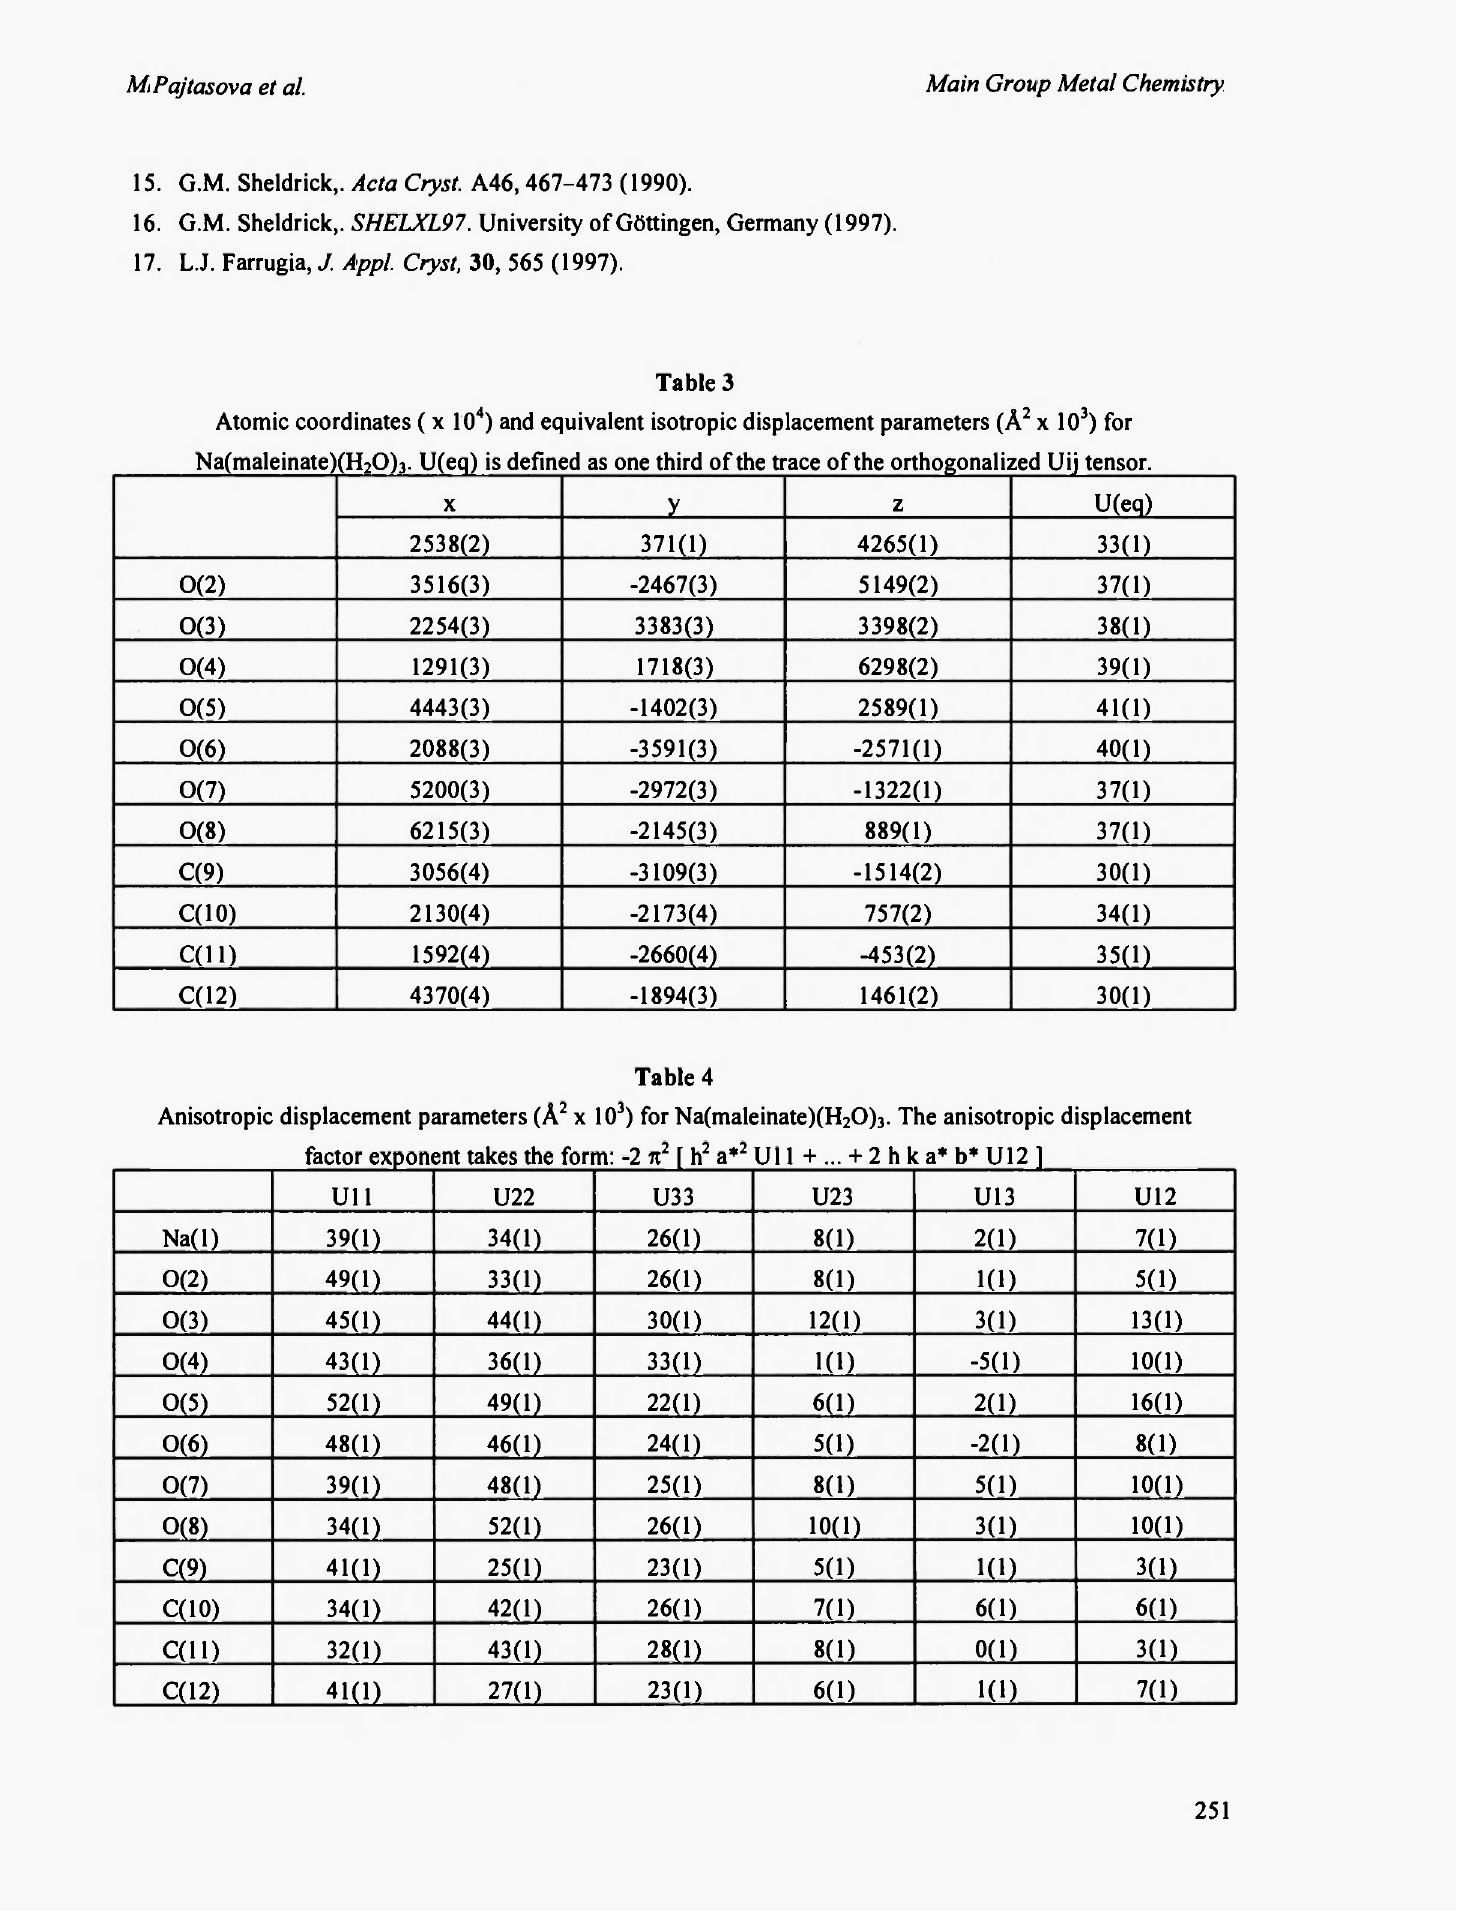
Atomic coordinates ( χ 1Ό 4 ) and equivalent isotropic displacement parameters (A 2 χ 10 3 ) for Na(maleinate)(H 2 0)3. U(eq) is defined as one third of the trace of the orthogonalized Ui j tensor.